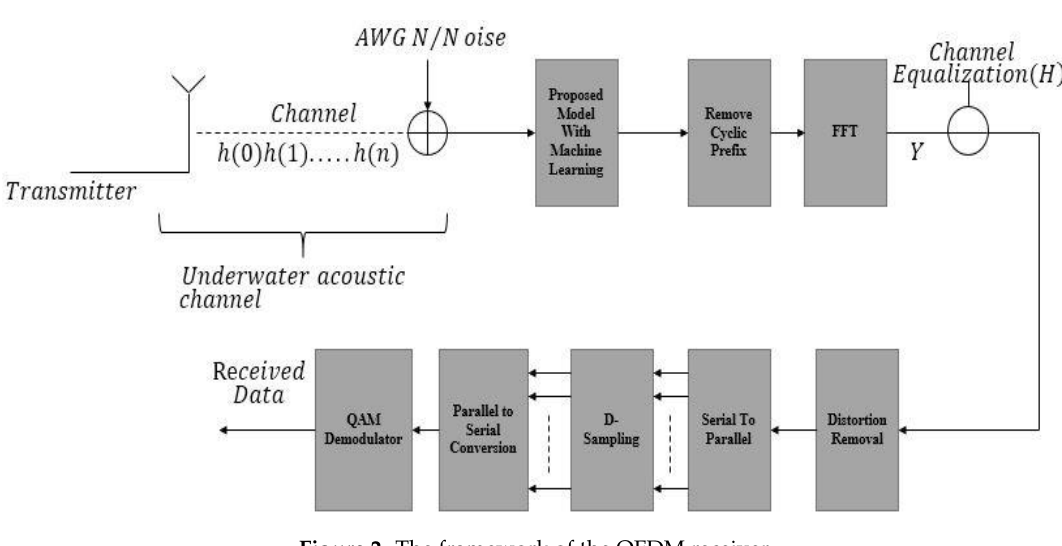
Figure 2. The framework of the OFDM receiver.